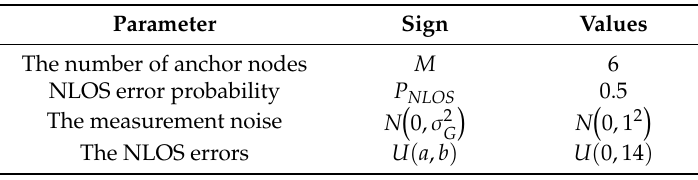
Table 2. Uniform distribution parameter.